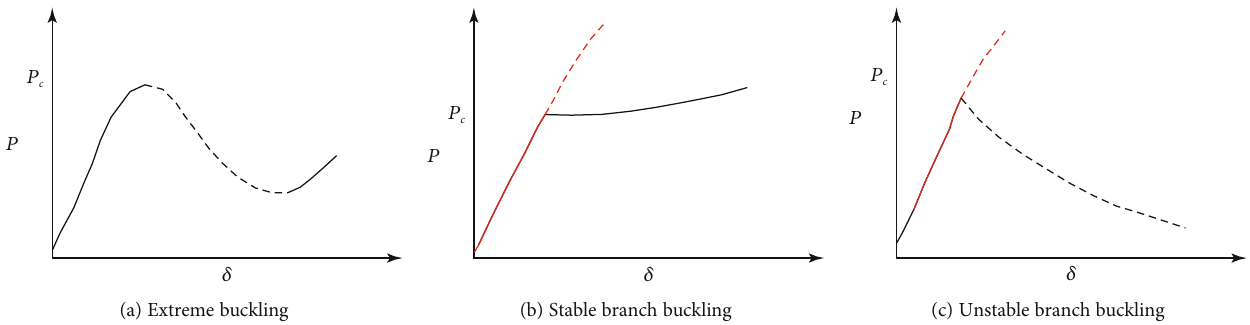
Figure 8: Load and displacement curves under di ff erent conditions.